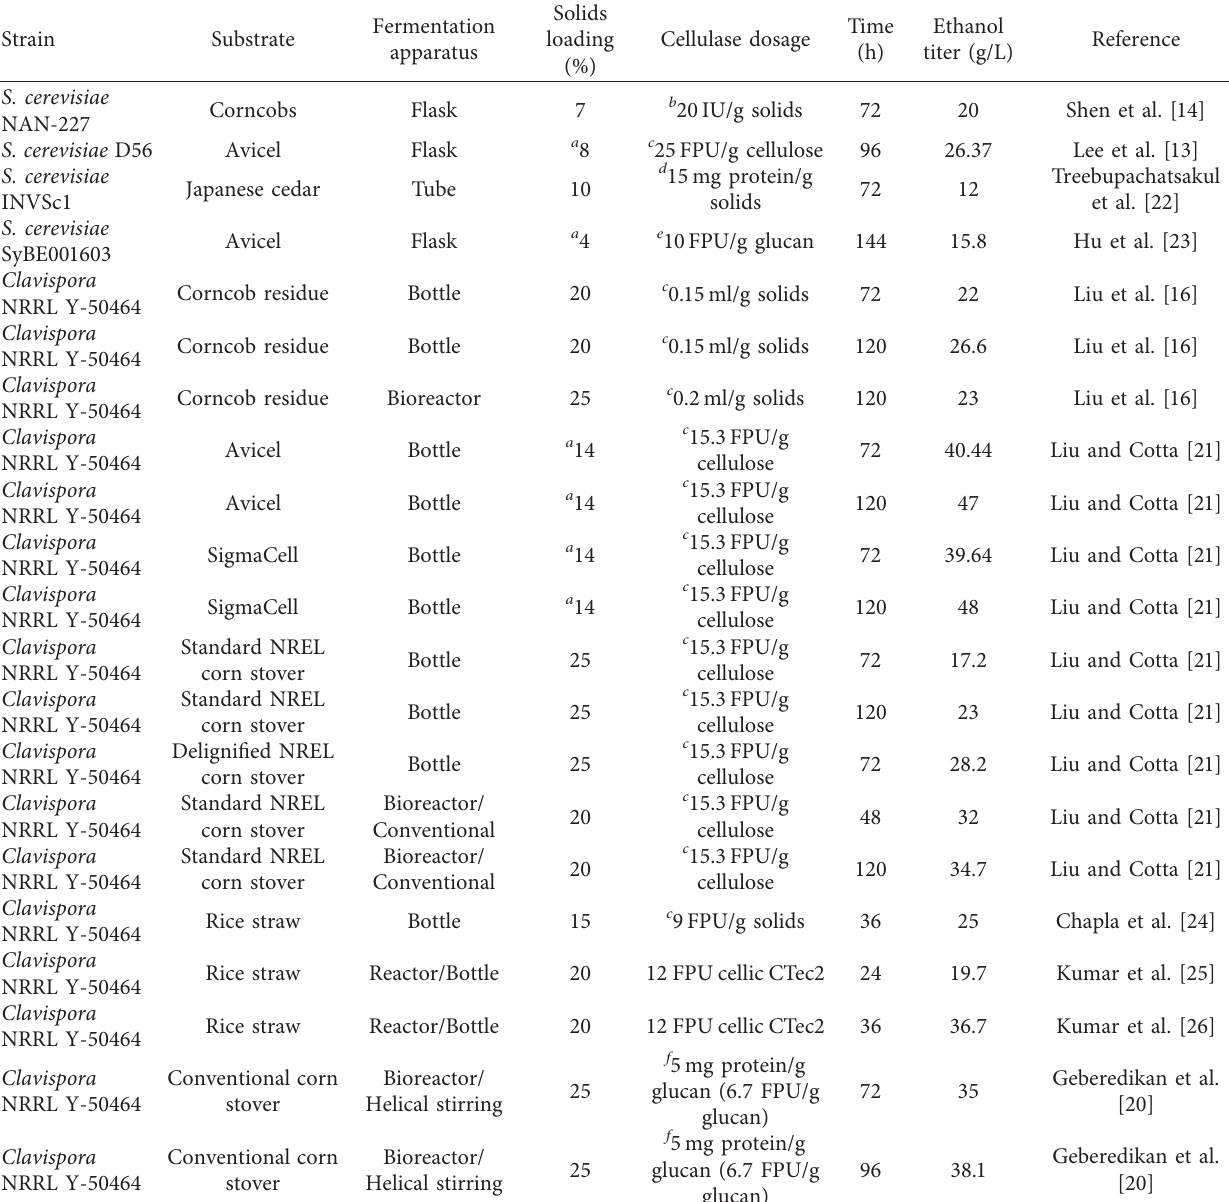
Table 1: A survey of cellulosic ethanol production using β -glucosidase-producing strains without the addition of extra β -glucosidase.